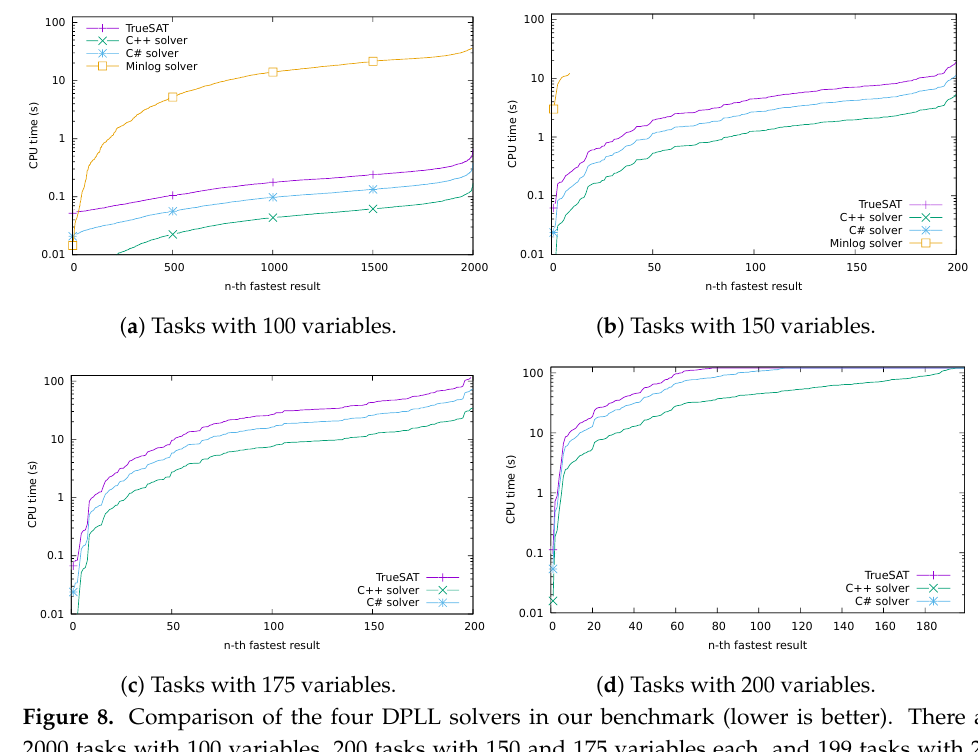
Figure 8. Comparison of the four DPLL solvers in our benchmark (lower is better). There are 2000 tasks with 100 variables, 200 tasks with 150 and 175 variables each, and 199 tasks with 200 variables. We plot the running time taken by the n-th fastest result for each solver. The y axis uses a logarithmic scale. The Minlog solver and TrueSAT are verified, while the C++ and the C# solvers are not. The running time of any solver on any given task is capped at 120s. The Minlog solver hits the memory limit on most tasks starting with 150 variables, and is therefore not shown in tasks with 175 and 200